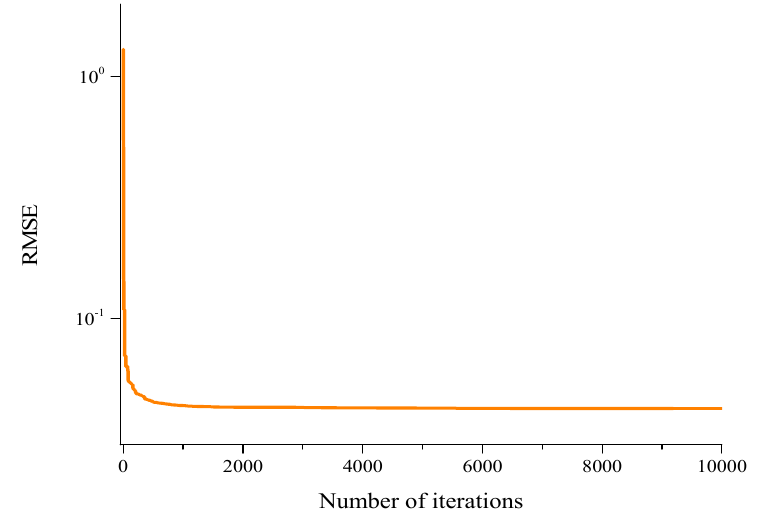
Figure 16. Convergence characteristics of DDM, JKM330P-72 PV module for curve 1.